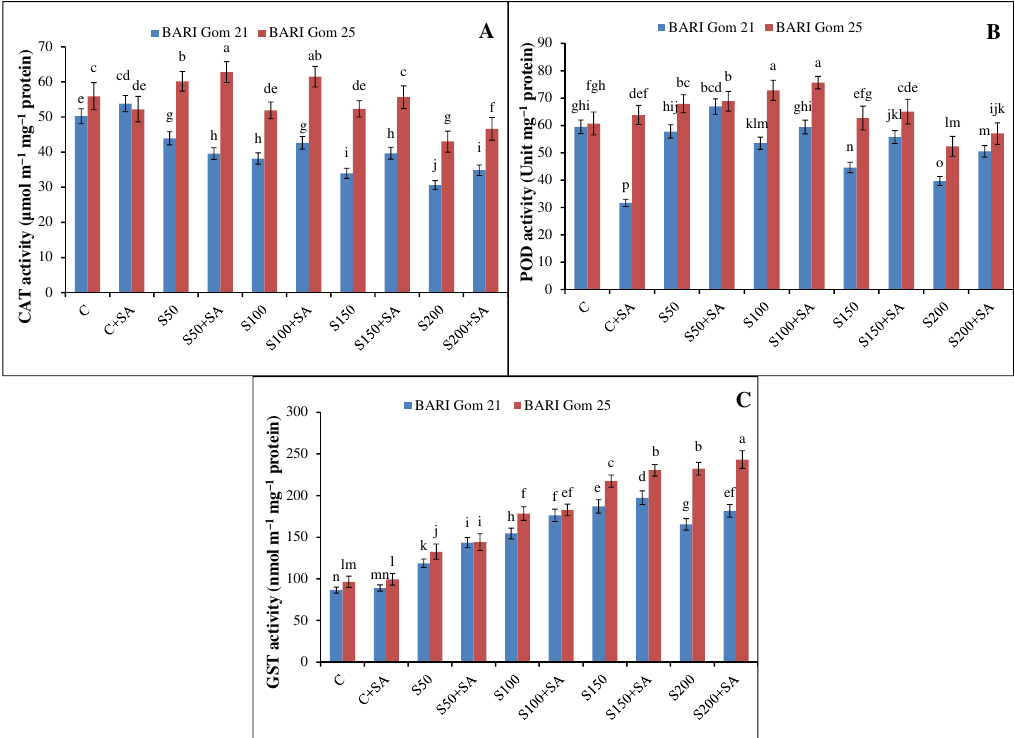
Fig. 5. ( A ) CAT activity, ( B ) POD activity and ( C ) GST activity in salt sensitive and salt tolerant wheat plants induced by exogenous salicylic acid under salt stress. S50, S100, S150 and S200 indicate 50 mM, 100 mM, 150 mM NaCl and 200 mM NaCl, respectively. In Y-axis, m -1 indicates ‘per minute’. SA indicates 1 mM salicylic acid spray, respectively. Mean (±SD) was calculated from three replicates for each treatment. Values in a column with different letters are significantly different at p ≤ 0.05 applying LSD